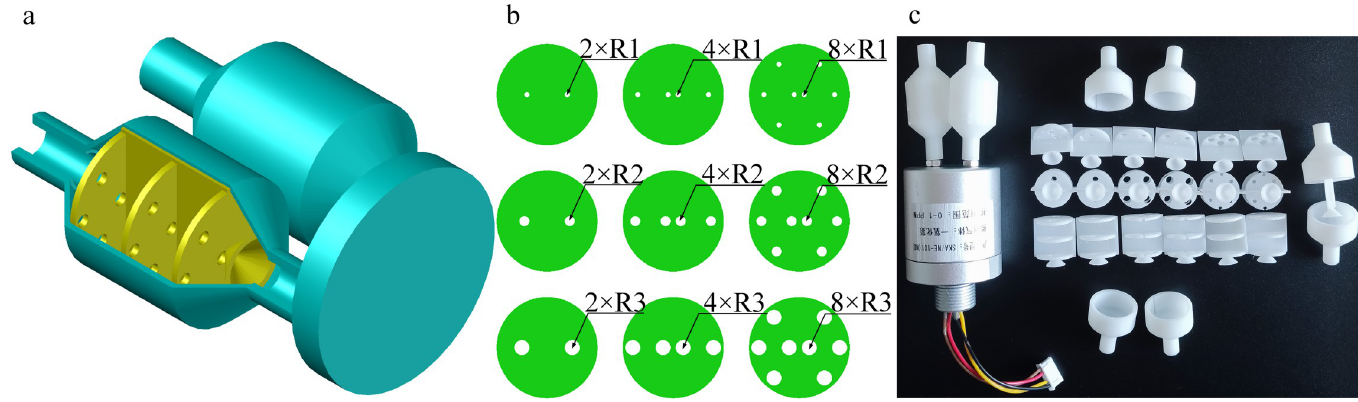
Fig 4. Sensing system mimicking canine ethmoturbinate. (a) Structural diagram of Chamber C. (b) Sieve plates of mimicking ethmoturbinate. (c) Actual picture of Chamber C.